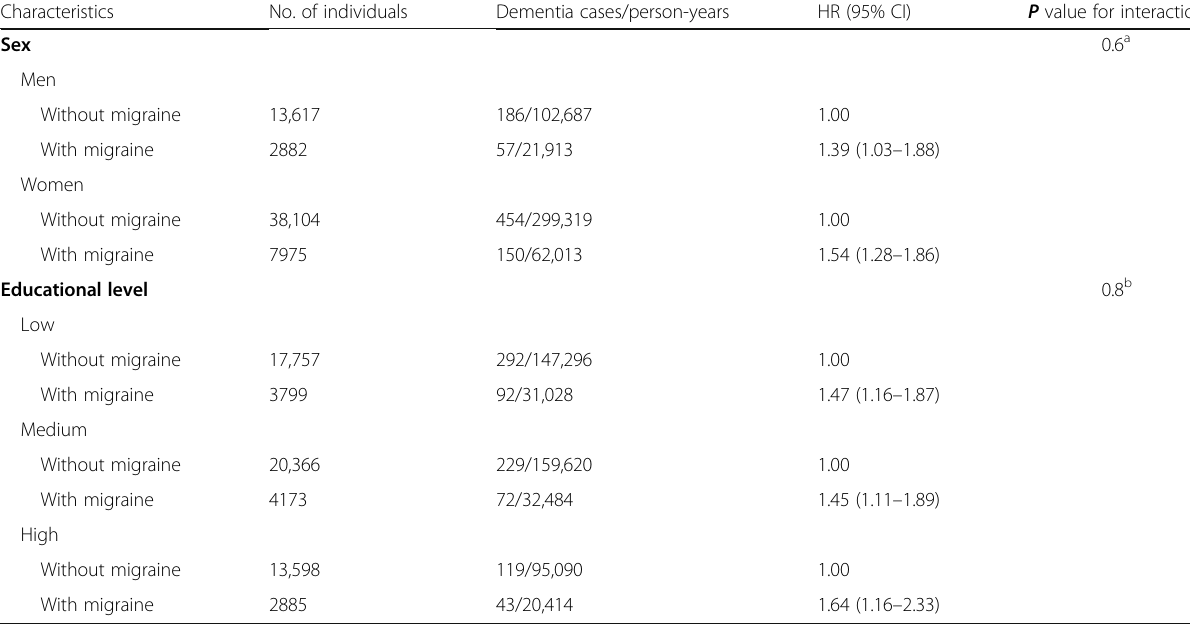
Table 4 Hazard rate ratios of dementia associated with migraine diagnoses grouped by sex or educational level ( N = 62,578)